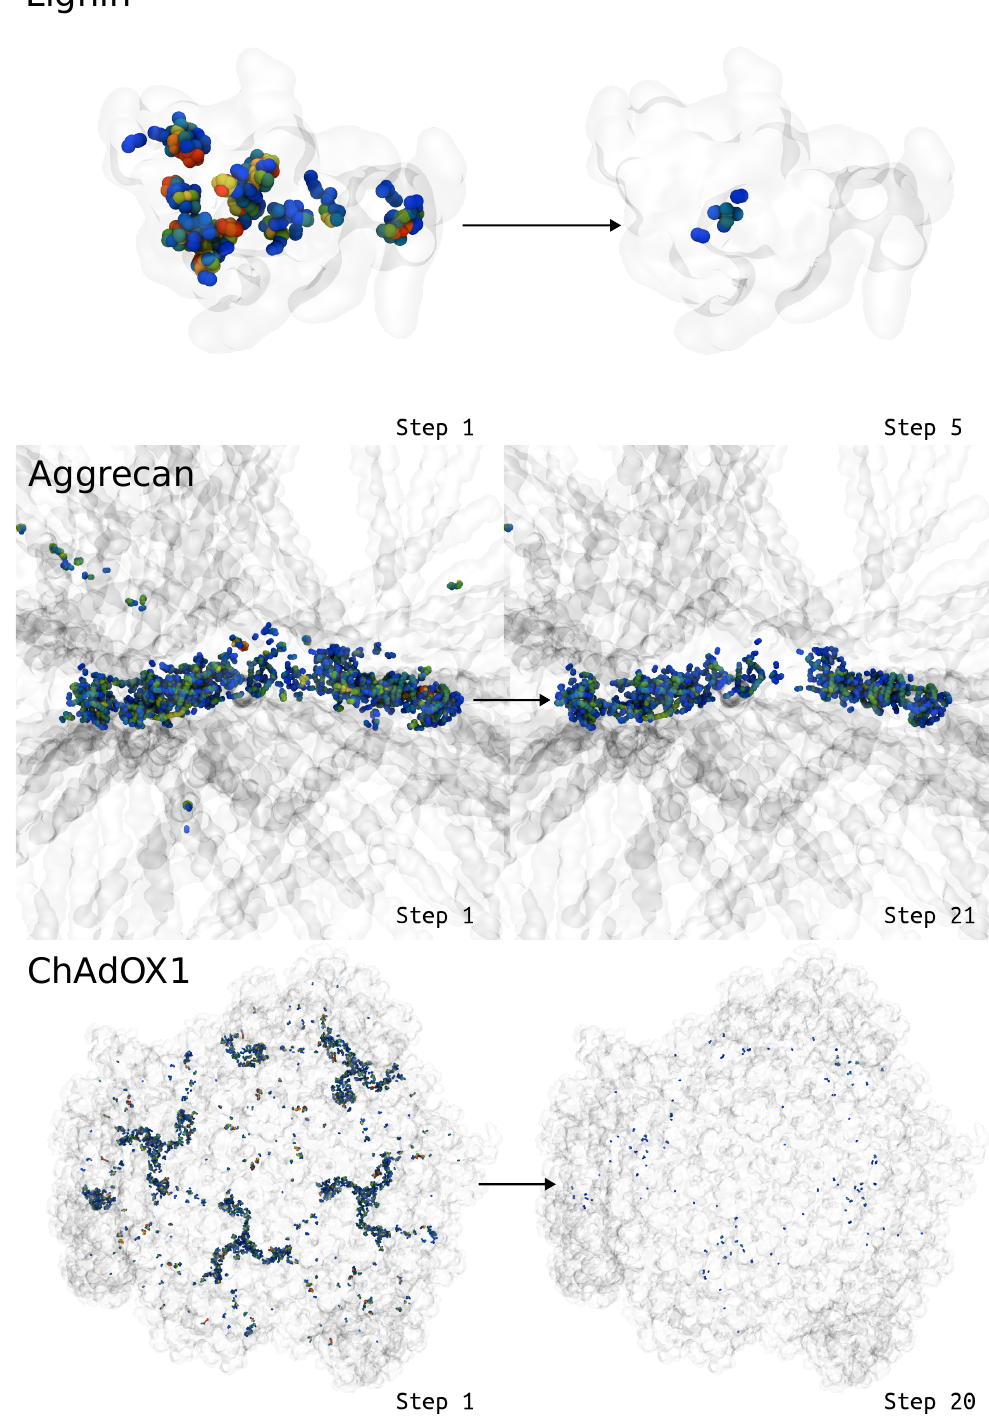
Figure 8. Visual representations for how the deviations change in the context of the larger biomolecule (transparent ghost), with atoms that demonstrate large bond deviations drawn as spheres and colored according to the sum of the bond deviations around a given atom. Blue colors represent small bond deviations, while redder colors represent larger bond deviations beyond 1Å. Note that for aggrecan, we zoom into the region with the greatest glycosylation density, as this was the most challenging region to deal with ring piercing interactions. Animations for these visualizations are available as Supporting